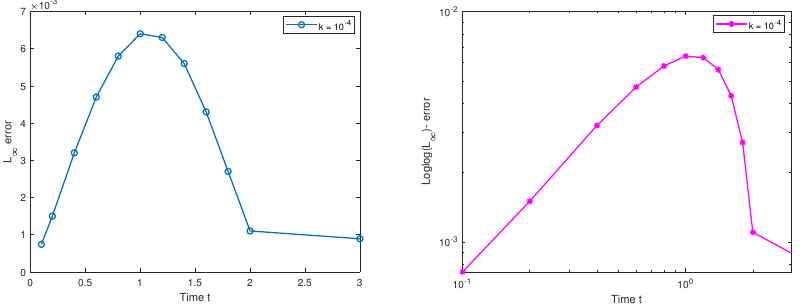
Figure 15. Plots of the maximum error vs. time t ∈ [ 0,3.0 ] and the loglog plot of max. error vs. time